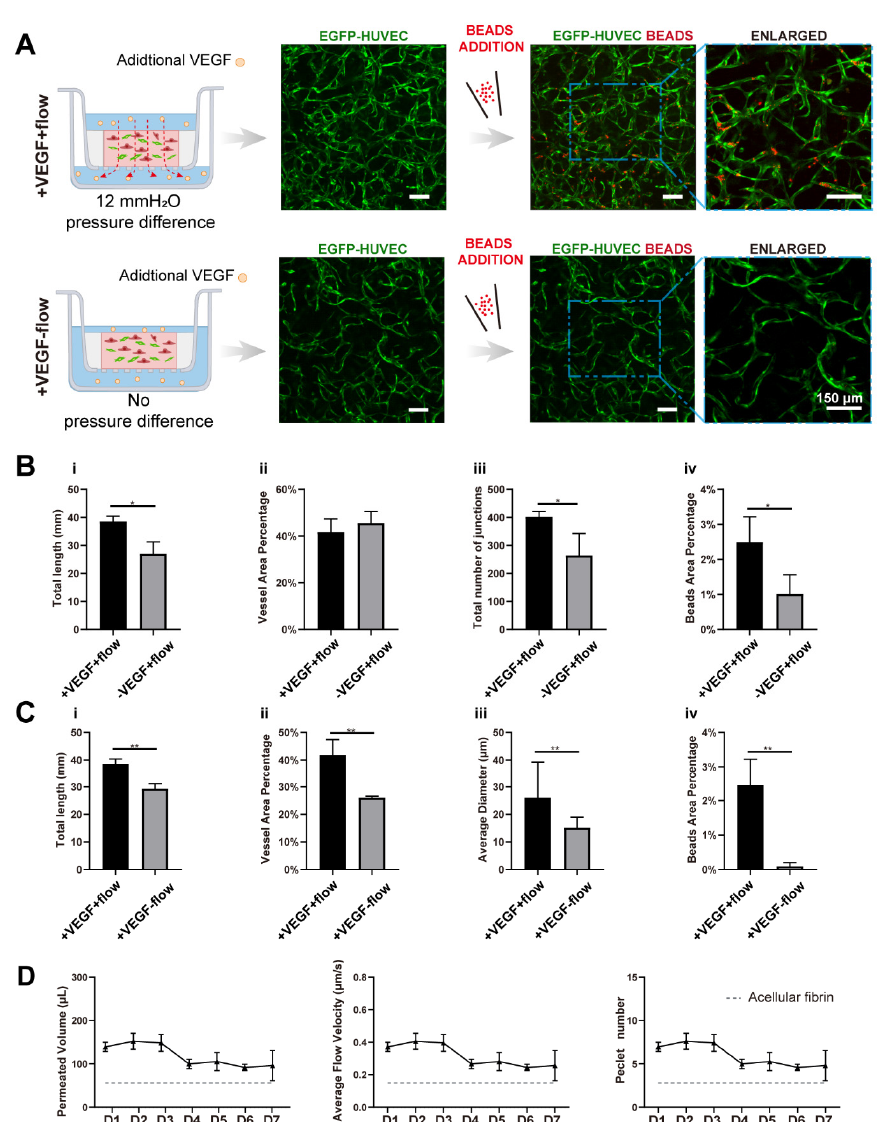
Figure 4. VEGF further amplified the vascular perfusability and morphological differences caused by interstitial flow in the presence of fibroblasts. ( A ) Confocal images of constructed vasculatures with additional VEGF, in the presence of NHLFs, and with/without flow. The constructed vessels were perfused with red beads to characterize the perfusability. Scale bar: 150 µ m. ( B ) The analyzed morphological statistics of the vessels developed with both flow and additional VEGF, and with flow but without additional VEGF, including total length ( i ), vessel area percentage ( ii ), total number of junctions ( iii ), and the beads area percentage ( iv ) which represented the perfusability of the vasculatures. The data was presented with the average value ± standard deviation ( n = 3). p -Values were calculated using the student’s t -test. *, p < 0.05. ( C ) The analyzed morphological statistics of the vessels developed with VEGF and with/without flow, including total length ( i ), vessel area percentage ( ii ), average diameter ( iii ), and the beads area percentage ( iv ) representing the perfusability of the vasculatures. The data was presented with the average value ± standard deviation ( n = 3). p -Values were calculated using the student’s t -test. **, p < 0.01. ( D ) The permeated volume, average flow velocity, and P é clet number statistics in the presence of both VEGF and NHLFs over 7 days period with the gray dash line indicating the acellular fibrin. The data was presented with the average value ± standard deviation ( n =